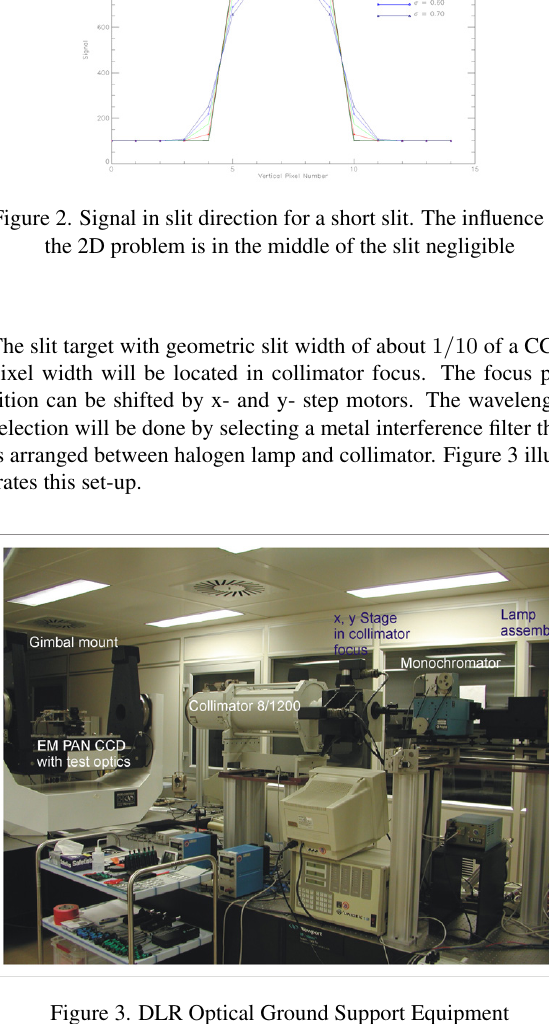
Figure 3. DLR Optical Ground Support